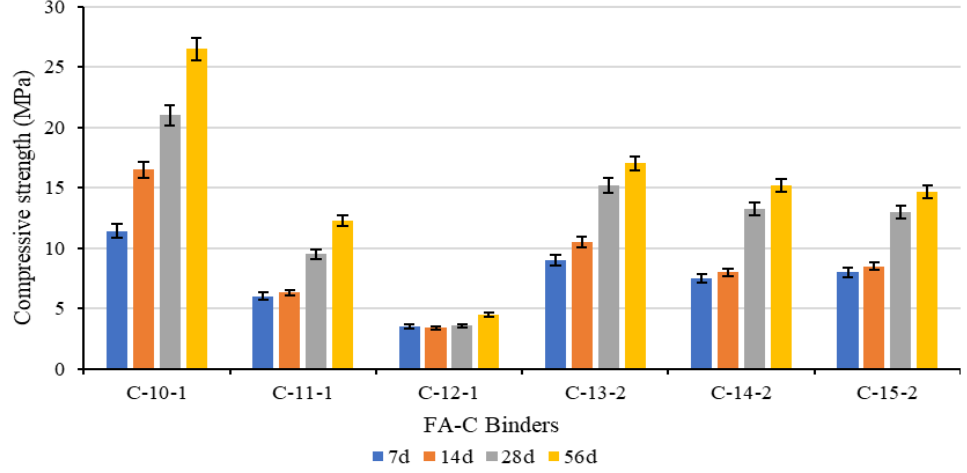
Figure 4. Influence of reagents (1 and 2) on fly ash class C